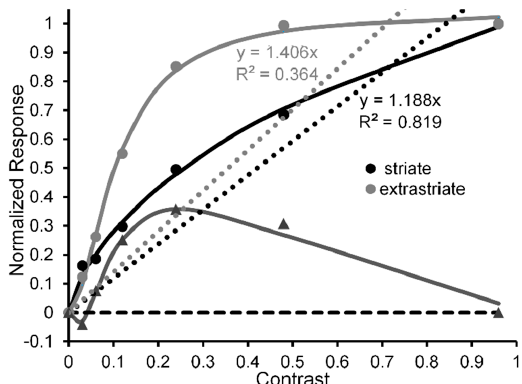
Figure 1. Normalized CRFs, indexed via MEG amplitude, obtained from human striate cortex (black lines and symbols) and extrastriate cortex (grey lines and symbols). Adapted from [24] with permission from the publisher.